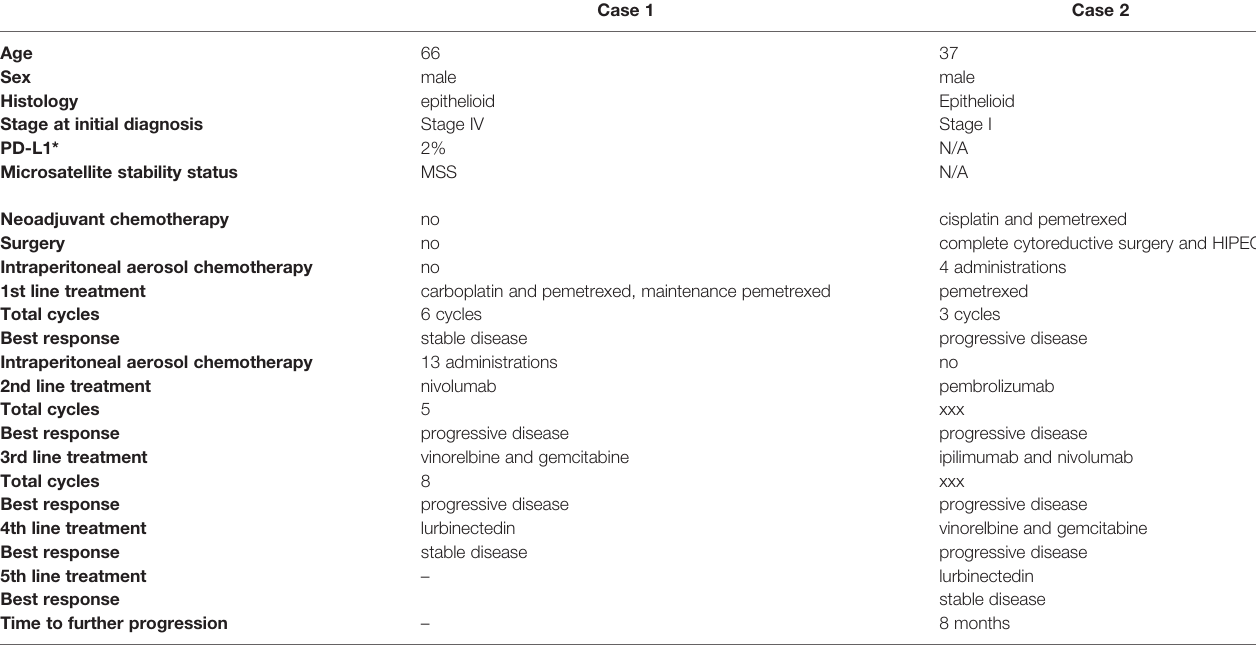
TABLE 1 | Clinical characteristics of both patients and overview of treatment